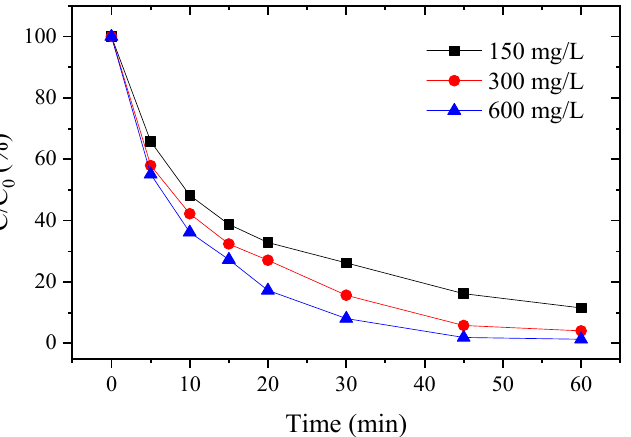
Figure 2. Effects of PDS amount on STZ removal. Conditions: [STZ] = 10 mg/L, [PDS] = 150–600 mg/L and UV irradiation: 2 mW/cm 2 .